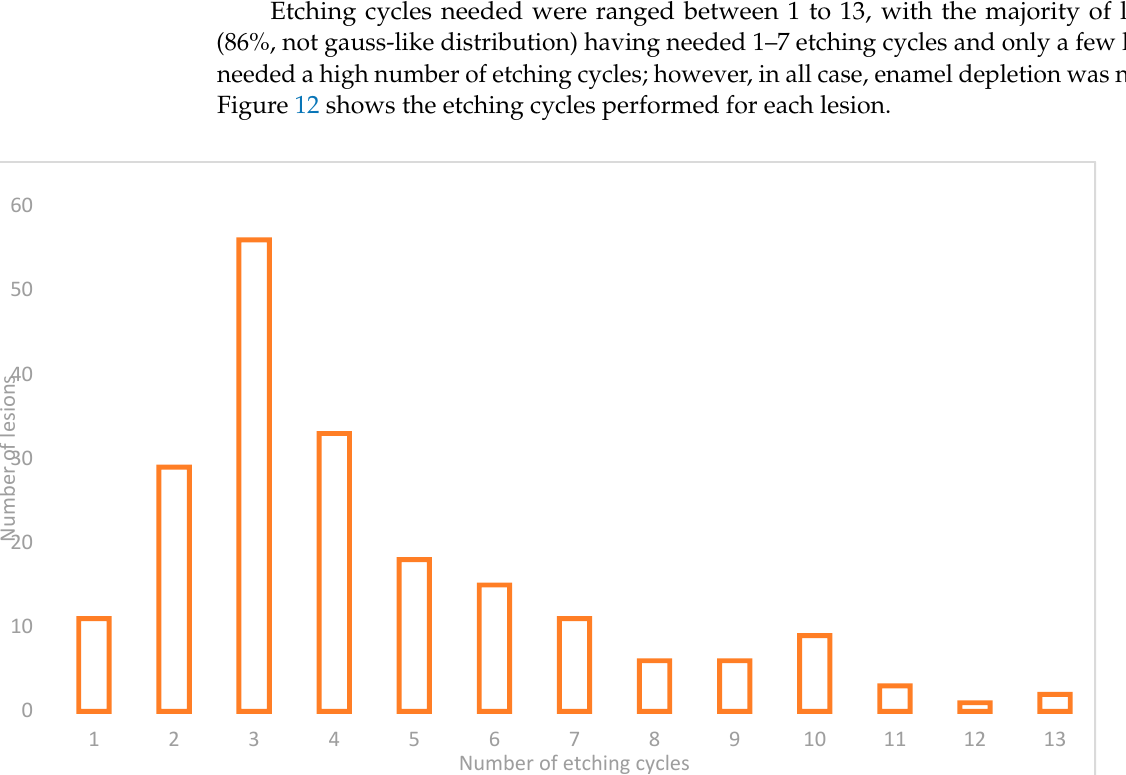
Table 3. Correlation between etching cycles and variables. Spearman’s correlation.